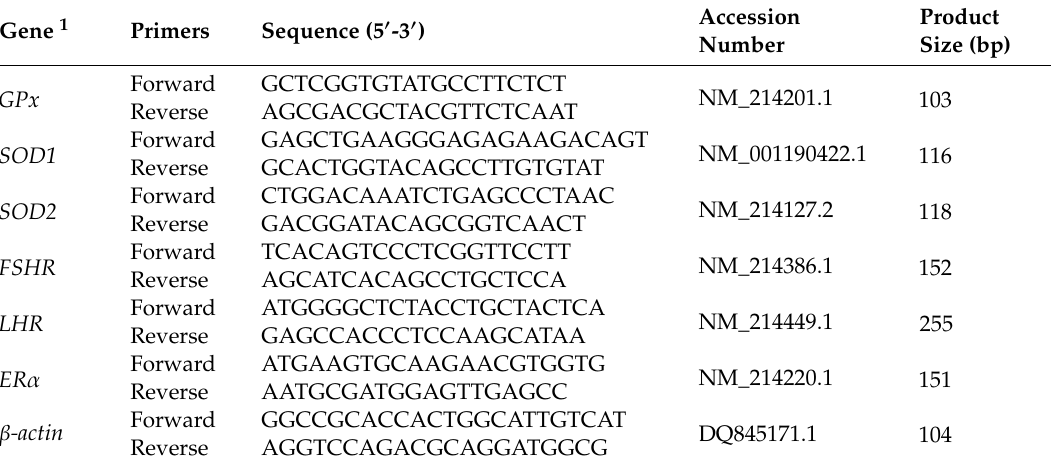
Table 3. Primer sequences of the target and reference